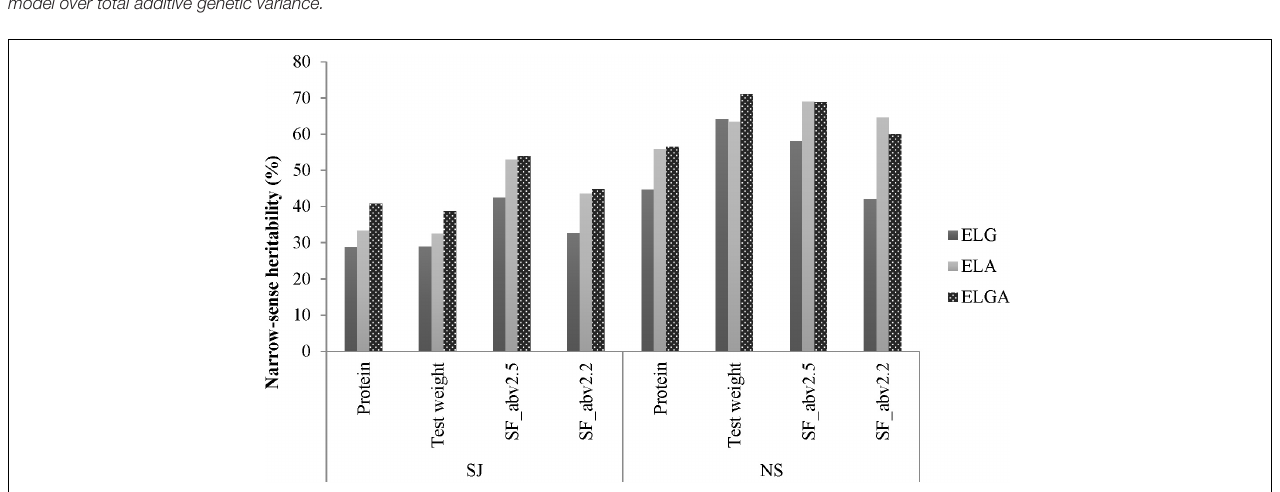
for protein, SF_abv2.5, and SF_abv2.2. In addition,